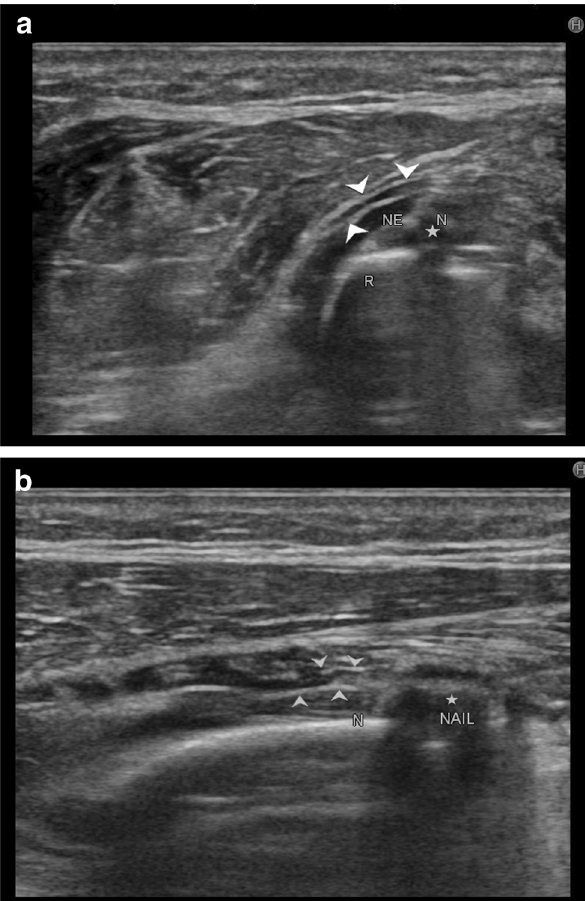
Fig. 9 a Arrowheads show posterior interosseous nerve (NE) being impinged by nail (N, star) following internal fixation in a case of fracture of both bones of forearm. b Arrowheads show posterior interosseous nerve getting impinged by implant (star). The nerve has a wavy contour but normal calibre. The patient underwent tendon transfer to relieve the finger